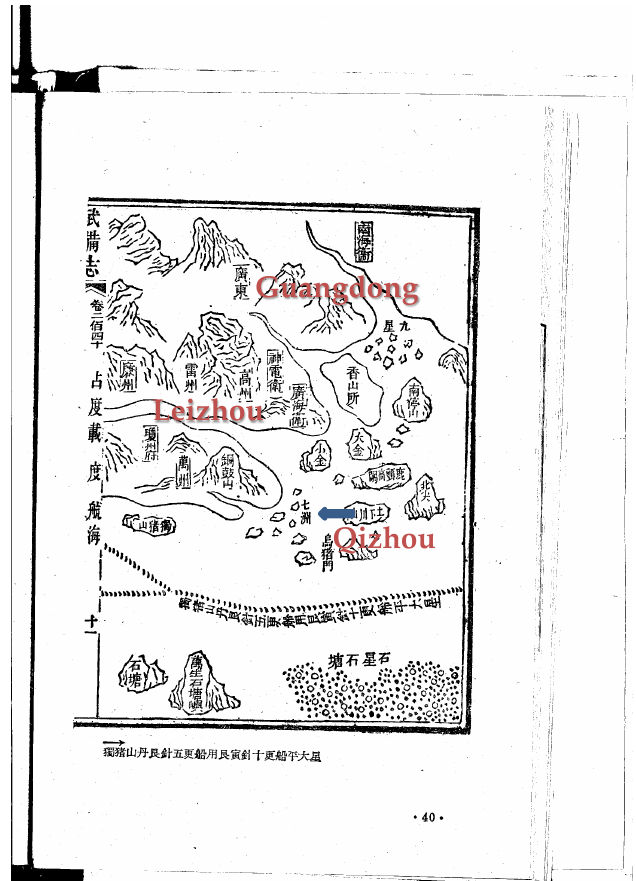
Figure 4. “Qizhou” (Seven Islands) in navigation maps. “Seven Islands” are in the middle of the map, while the dot-line below it indicates the sea route for ships. Zheng He hanghai tu (The Navigation Maps of Zheng He’s Expedition) , p.